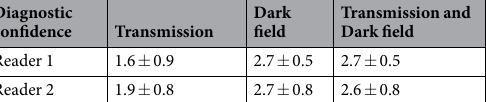
Table 2. Diagnostic confidence indicated by reader 1 and reader 2 for interpretation of transmission and dark- field images, either evaluated separately or